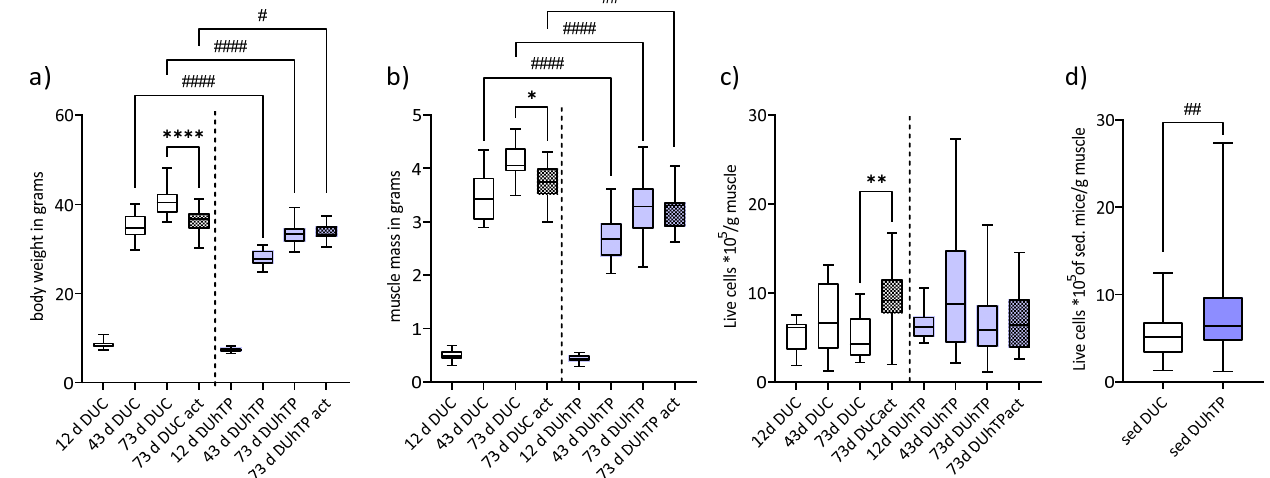
Figure 3. ( a ) Body weight and ( b ) muscle mass of all limbs of 12-, 43-, and 73-day-old male DUC (white bars) and DUhTP mice (blue bars), with older mice either sedentary or active in a running wheel (act). A total of 85 DUC (12 d: 20, 43 d: 22, 73 d: 26, 73 d act: 17) and 72 DUhTP mice (12 d: 16, 43 d: 18, 73 d: 22, 73 d act: 16) were included in the analyses. Satellite cells were isolated from whole limb muscles, and (c-d) the cell yield per gram of muscle was considered ( c ) for each age (DUC 12 d: 16, 43 d: 22, 73 d: 22, 73 d act: 17 mice; DUhTP 12 d: 16, 43 d: 18, 73 d: 22, 73 d act: 16 mice) and activity group or ( d ) holistically from all sedentary (sed) mice of a mouse line (DUC: n = 68 mice; DUhTP: n = 56 mice). Results are shown as means and SD, and statistical analyses were performed using one-way ANOVA ( a – c ) or unpaired t -test with Welch’s correction. Significant line-specific differences (DUC versus DUhTP mice) are marked by hashtags ( # p < 0.05; ## p < 0.01; #### p < 0.0001), while activity-induced differences (act versus sedentary) within the mouse lines are indicated by asterisks (* p < 0.05; ** p < 0.01;**** p < 0.0001).